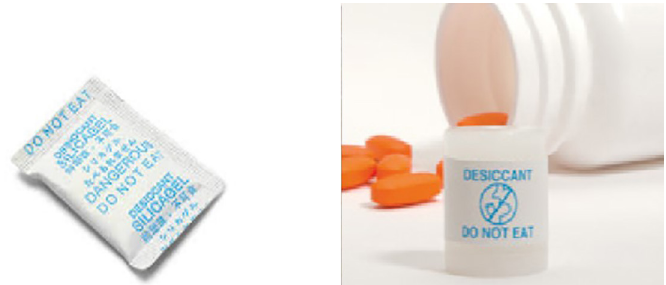
Image 1. (Left) Image of traditional desiccant package. 1 (Right) Image of new desiccant cylindrical canister for medications.